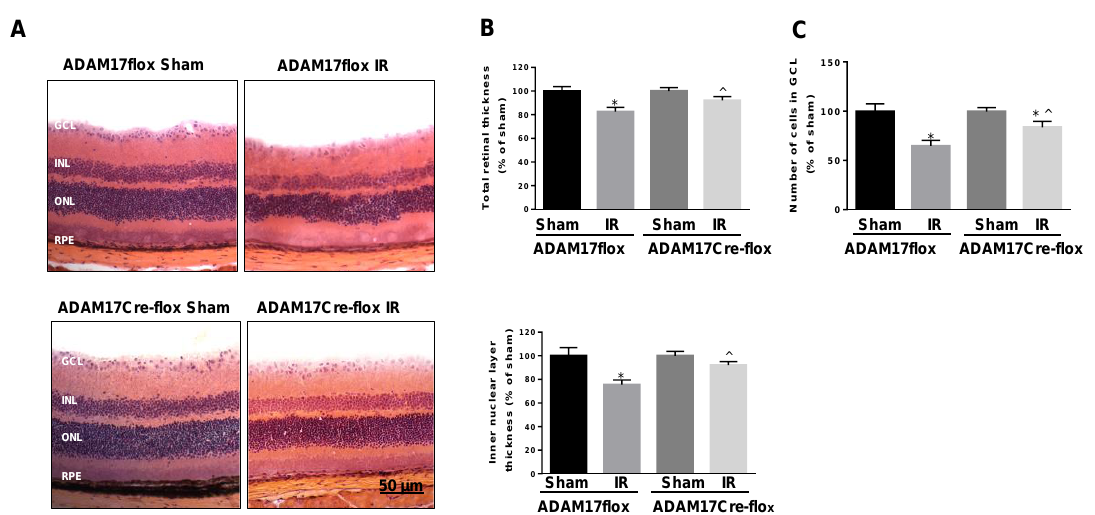
Figure 3. Endothelial ADAM17 is involved in IR-induced neuronal degeneration. ( A ) Representative hematoxylin and eosin stained retinal cryosections (mid-peripheral field) from IR-injured and sham-operated eyes of control ADAM17flox and ADAM17Cre-flox mice 7 days after ischemic insult. Scale bar, 50 µ m. ( B ) Morphometric analysis of retinal cryosections: total retinal thickness and thickness of the INL. Data are expressed as mean ± SE and presented as a percent change from sham. * p < 0.01 vs. corresponding sham; ˆ p < 0.05 vs. ADAM17flox IR; n = 5 for each group. ( C ) Quantification of cells in the GCL of IR-injured and sham-operated eyes of control ADAM17flox and ADAM17Cre-flox mice 7 days after ischemic insult. Data are expressed as cell number / 100 µ m retinal length and presented as a percent change from sham. * p < 0.001 vs. corresponding sham. ˆ p < 0.0001 vs. ADAM17flox IR; n = 5 in each group.